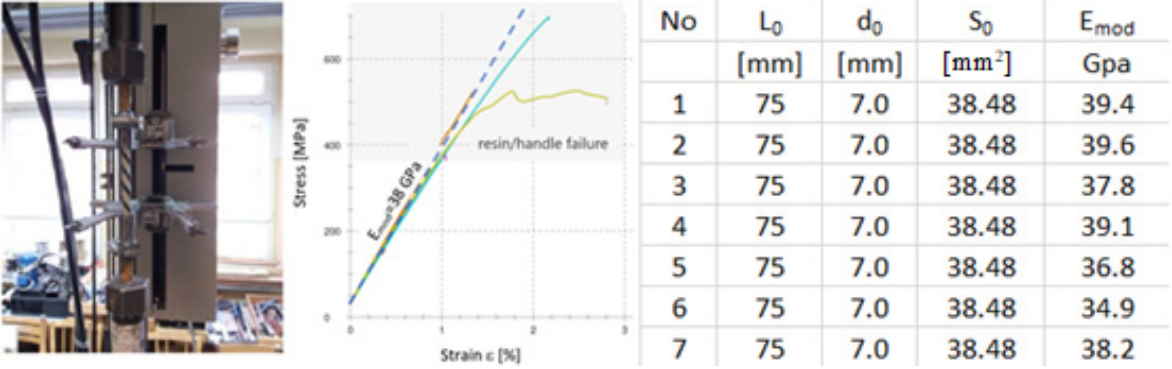
Figure 2. Testing of composite rebar. Table 2. Mechanical and physical properties of used reinforcement.